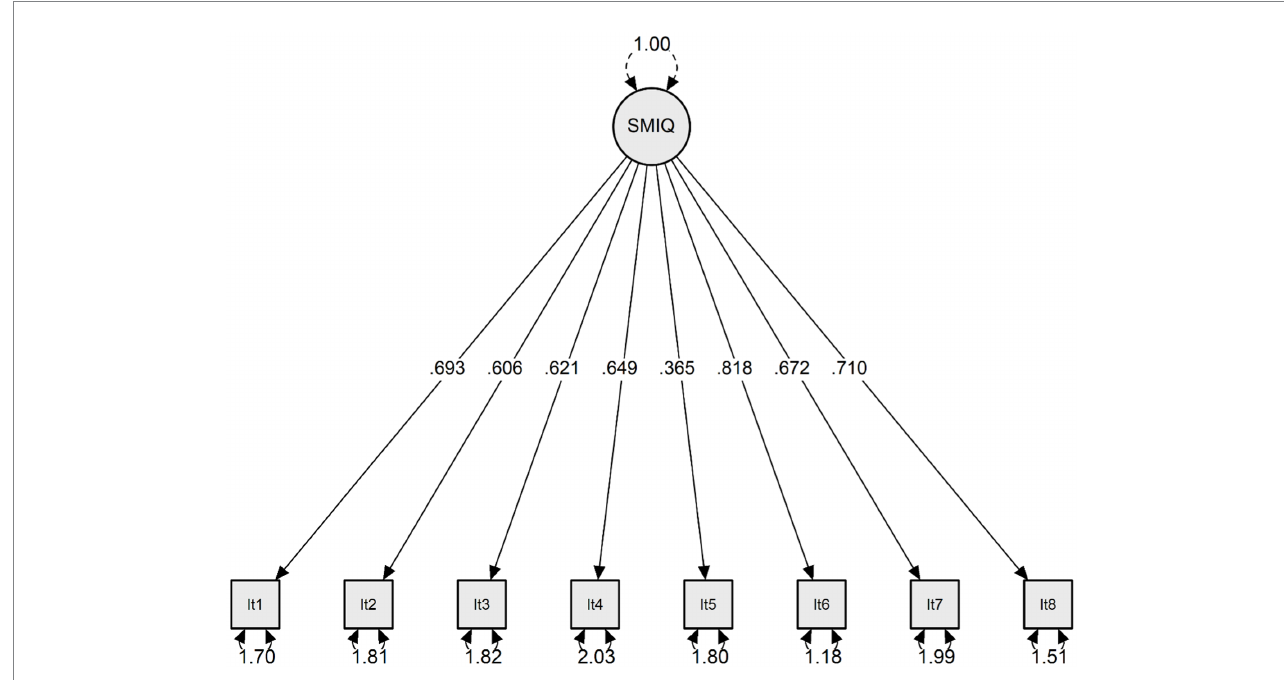
FIGURE 1 Standardized model parameters for the confirmatory factor analysis: the uni-mode of the SMIQ. SMIQ = social media intrusion